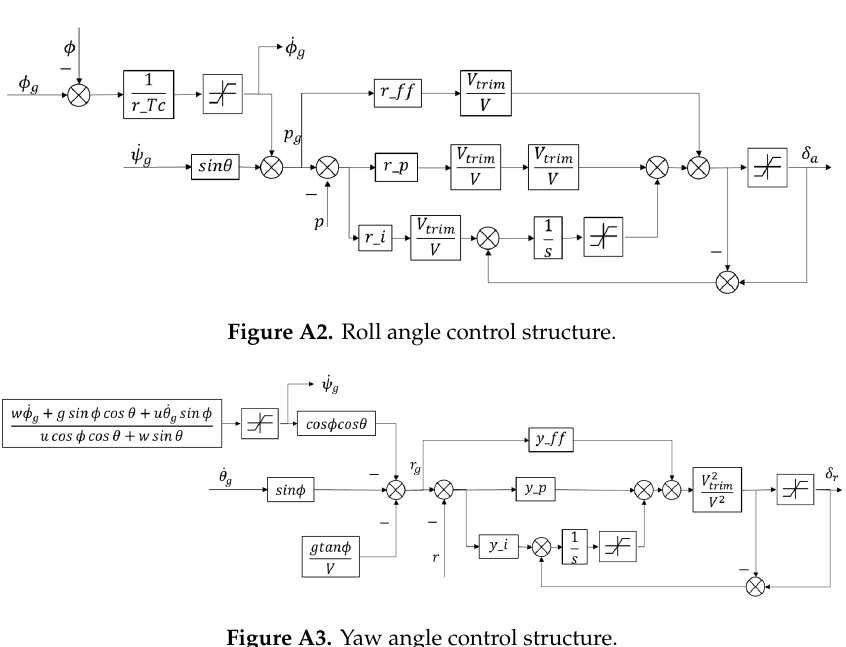
Figure A3. Yaw angle control structure. Figure B3. Yaw angle control structure. Figure B3. Yaw angle control structure.